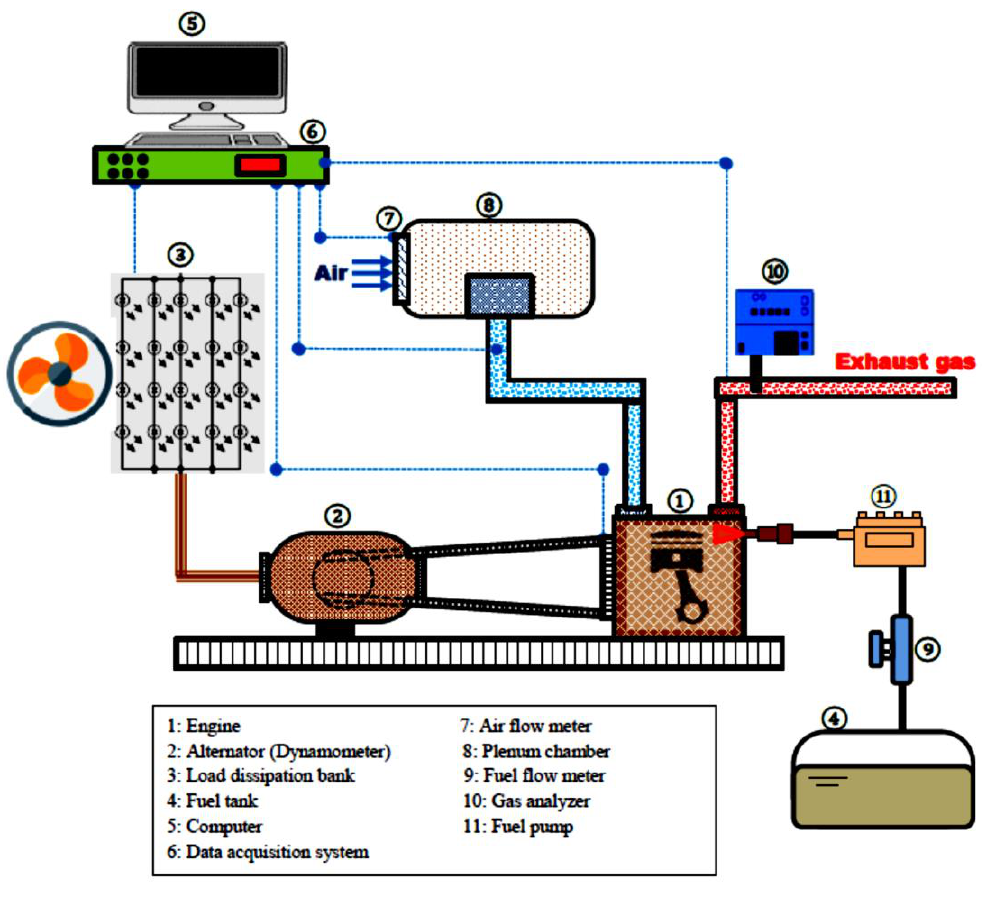
Figure 4. Engine test rig. Table 2. Engine test rig specifications.